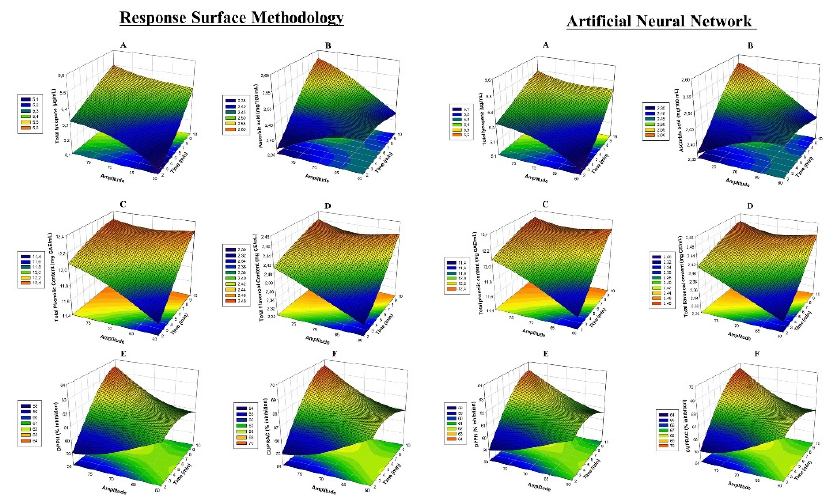
Figure 1. Response surface plots (3D) for TL ( A ), TAC ( B ), TPC ( C ), TFC ( D ), DPPH ( E ) and